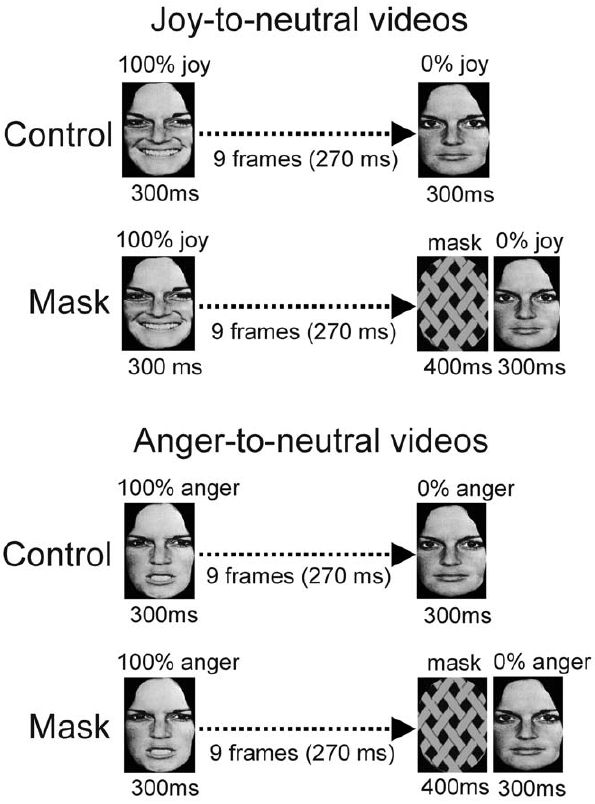
Figure 7. Illustration of the stimulus presentations in Experi- ment 4. Joy-to-neutral videos (top panel) and Anger-to-neutral videos (bottom panel) in the Control and Mask conditions are shown.